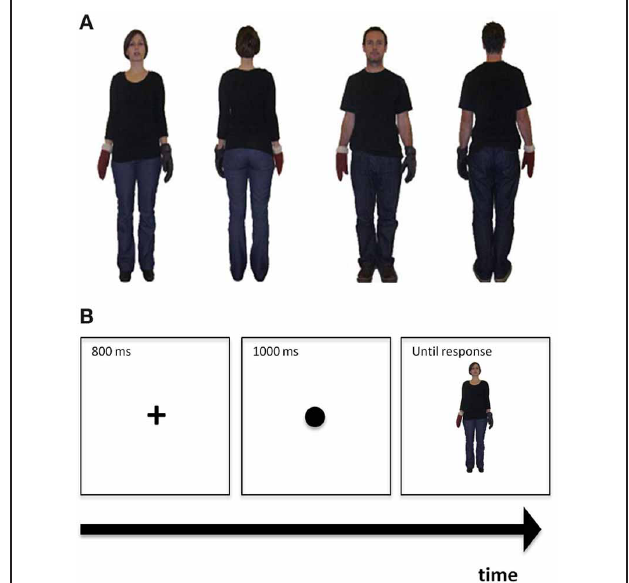
FIGURE 1 | (A) Examples of figures used in the perspective taking task. From left to right: The first two frames illustrate front- and back- facing female figures, while the remaining two frames depict front- and back- facing male figures. (B) Demonstration of the perspective taking task procedure: The cross is presented first, followed by the coloured dot, followed by the figure.